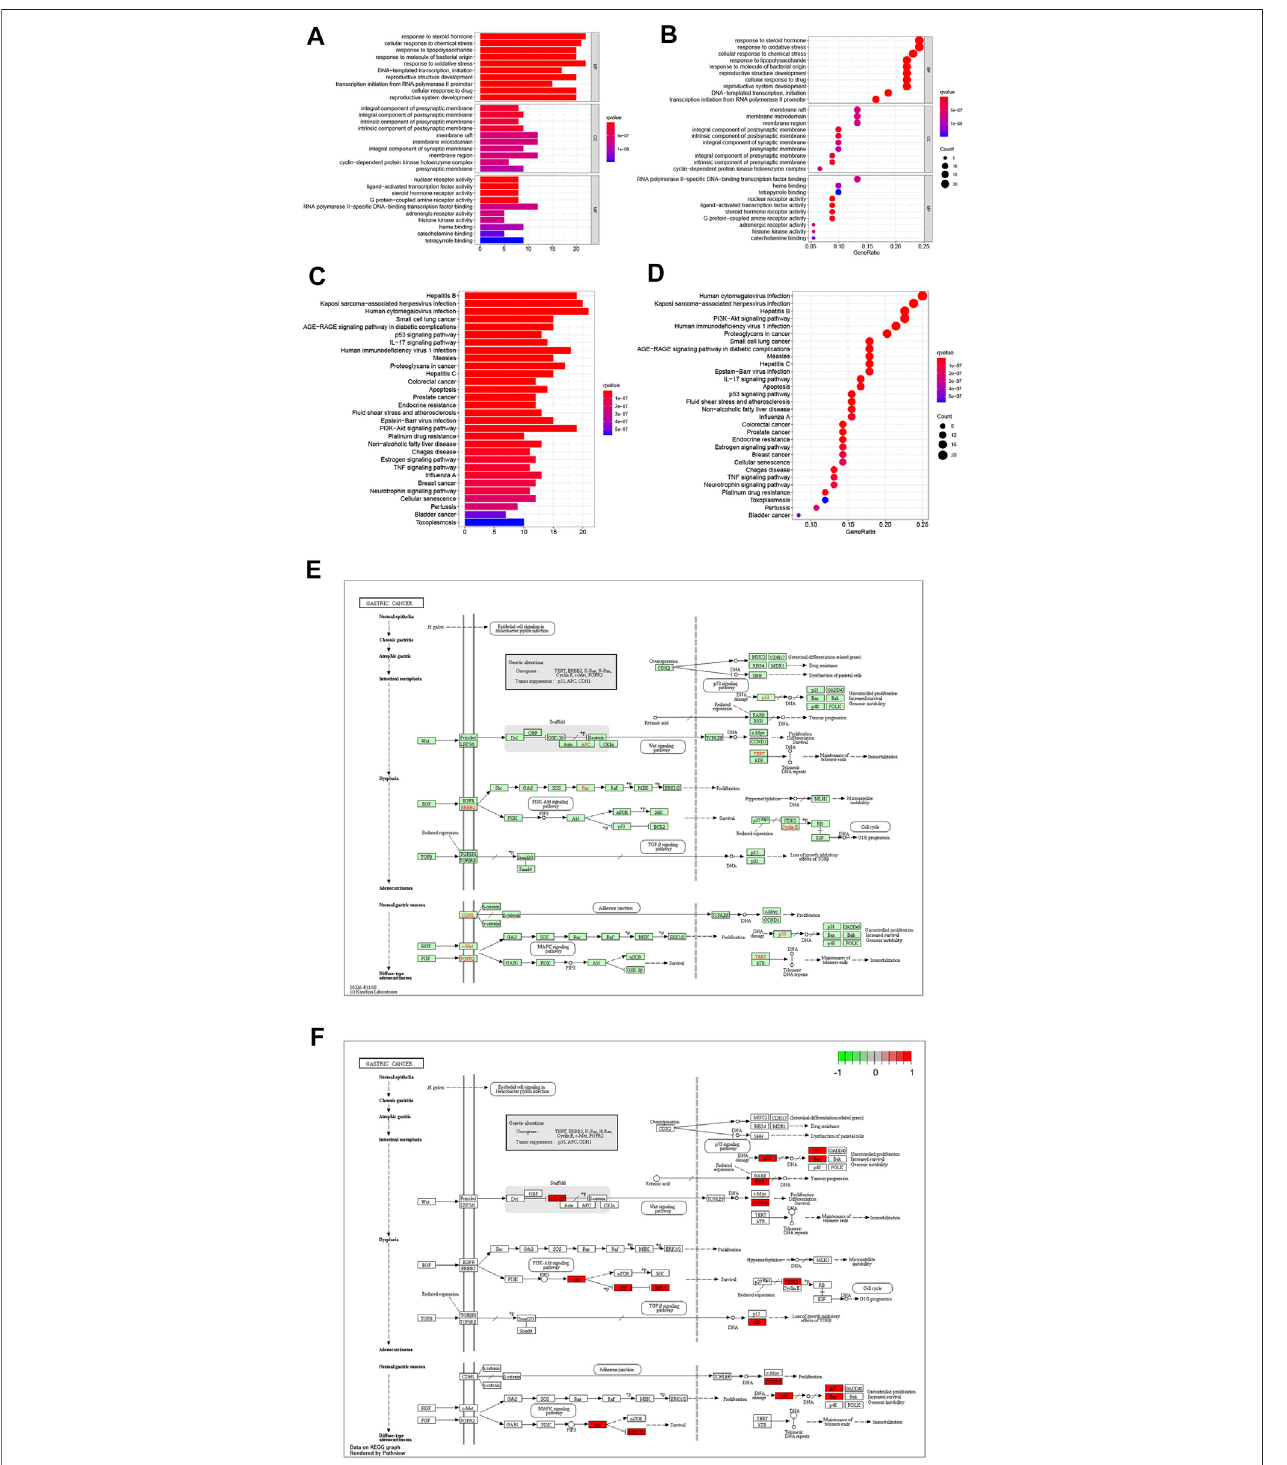
FIGURE3 |(A) Bar graphof GOenrichmentanalysisoftarget genesof Scutellaria baicalensis in antigastric cancer. (B) Bubble graph ofGOenrichmentanalysisof targetgenesof Scutellariabaicalensis inantigastriccancer. (C) KEGGenrichmentoftargetgenesof Scutellariabaicalensis inantigastriccancerBargraphofanalysis. (D) BubblechartofKEGGenrichmentanalysisoftargetgenesof Scutellariabaicalensis Georgionantigastriccancer;3E:KEGGsignalingpathwayof Scutellariabaicalensis ’ antigastric cancer effect. (F) Key molecules of Scutellaria baicalensis antigastric cancer effect.